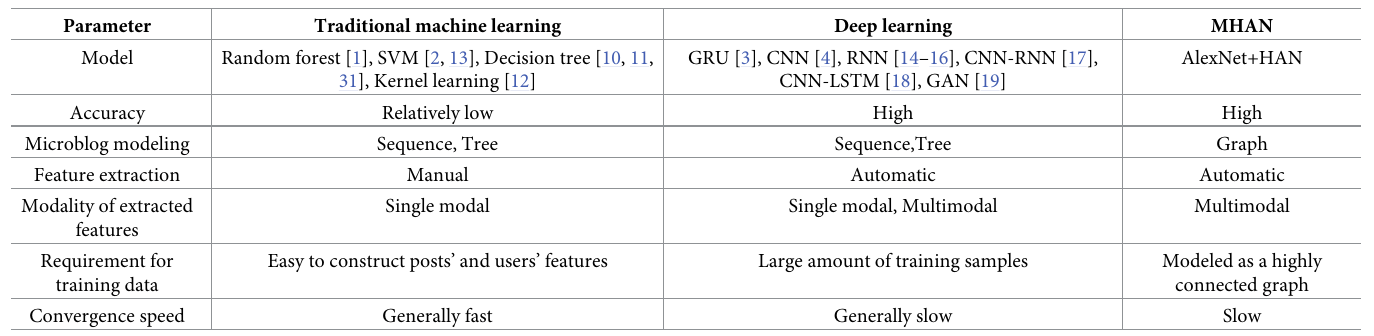
Table 5. Summarisation of the benefits and limitations of existing methods and MHAN.